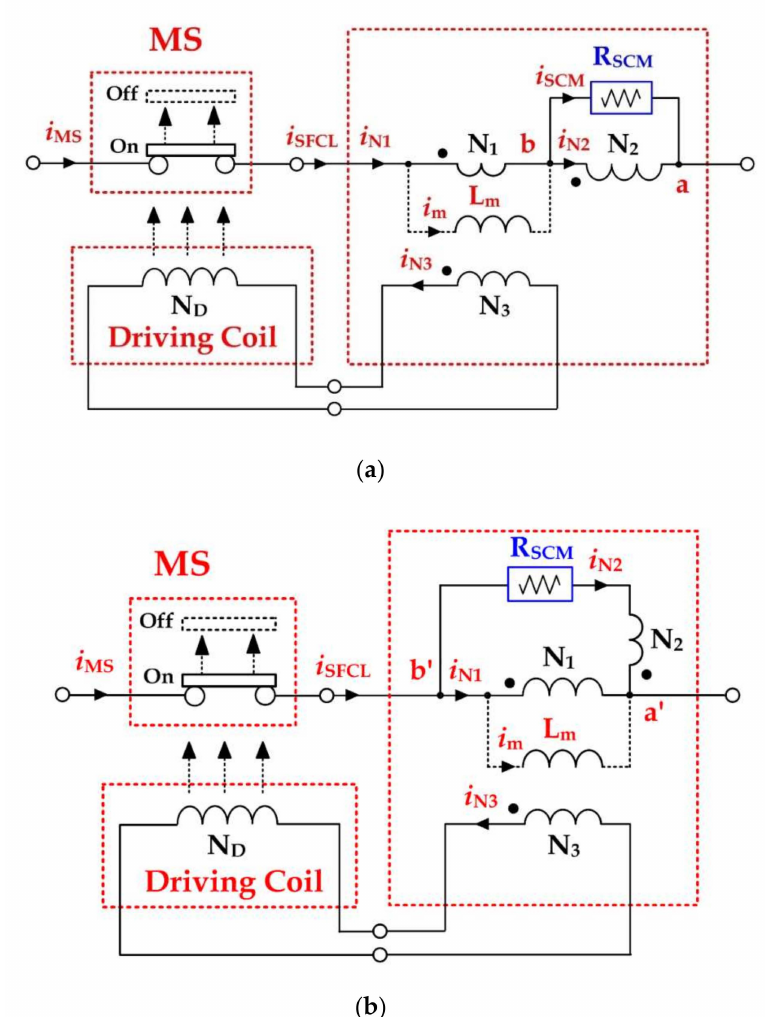
Figure 3. Electrical equivalent circuit of proposed SFCLB using flux coupling with a tap changer. ( a ) In the case that the two taps (A, B) move into a and b (series connection) ( b ) In the case that the two taps (A, B) move into a’ and b’ (parallel